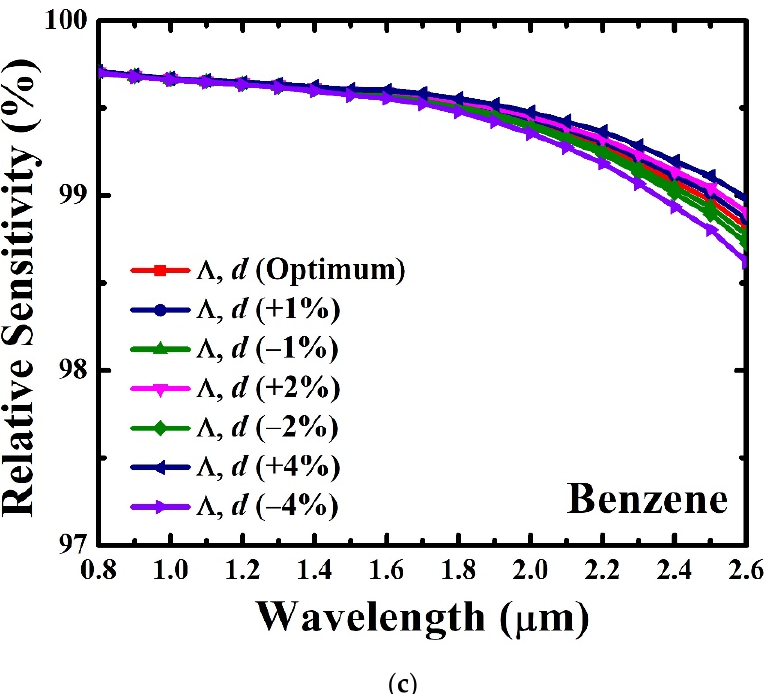
Figure 9. ( a ) Tolerance analysis of relative sensitivity for water in the variations of ±1%, ±2% and ±4%. ( b ) Tolerance analysis of relative sensitivity for ethanol in the variations of ±1%, ±2% and ±4%. ( c ) Tolerance analysis of relative sensitivity for benzene in the variations of ±1%, ±2% and ±4%.